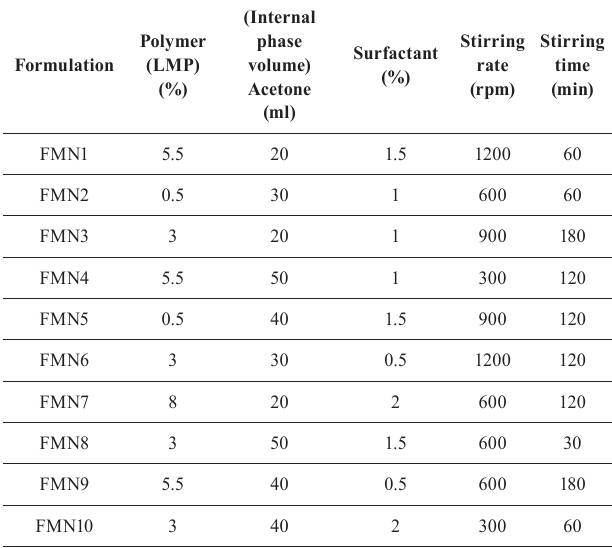
TABLE I - T aguchi orthogonal array design in